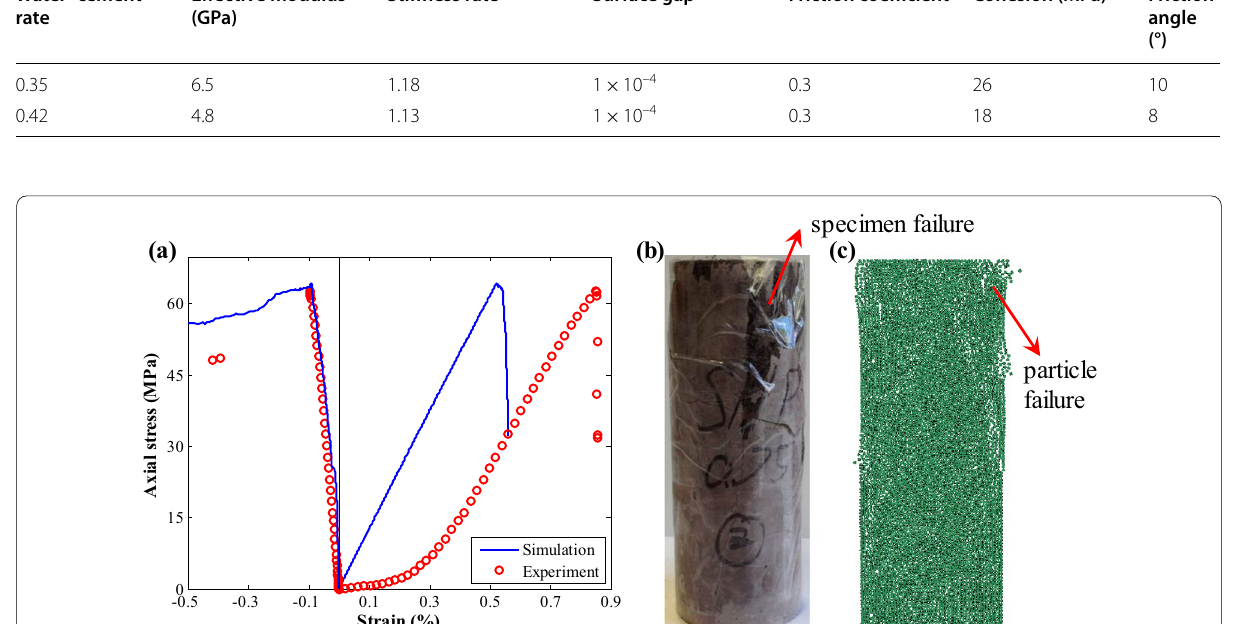
Fig. 11 Comparison between the numerical and experimental UCS results when the water–cement rate was 0.35: a stress–strain curves; b experimental failure mode; c numerical failure mode.